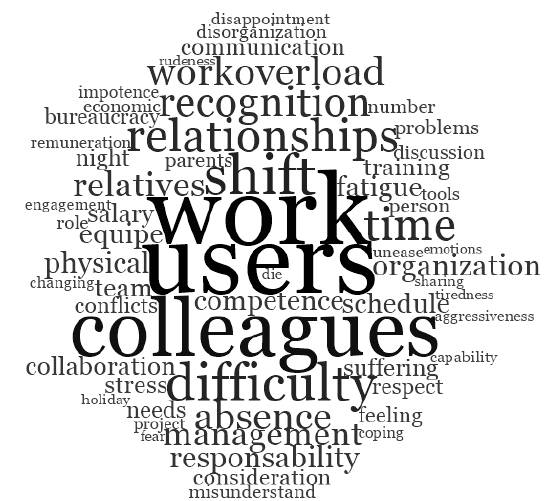
Figure 2. Words used to describe the three risk factors of well-being at work.